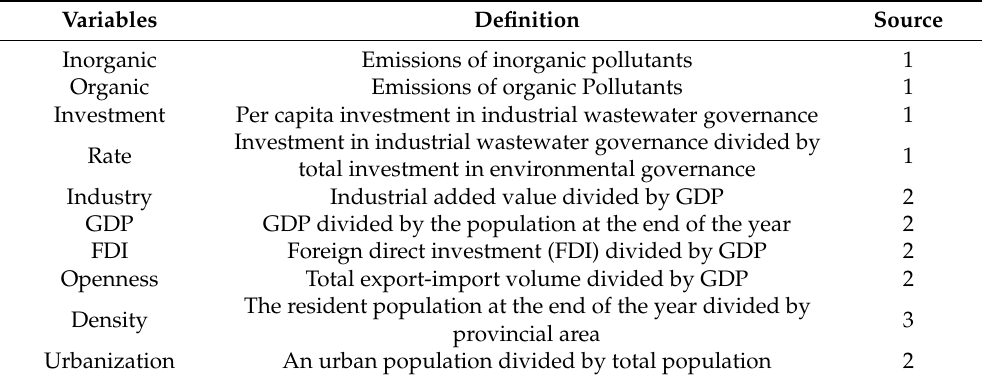
Table 1. Definition of variables and data